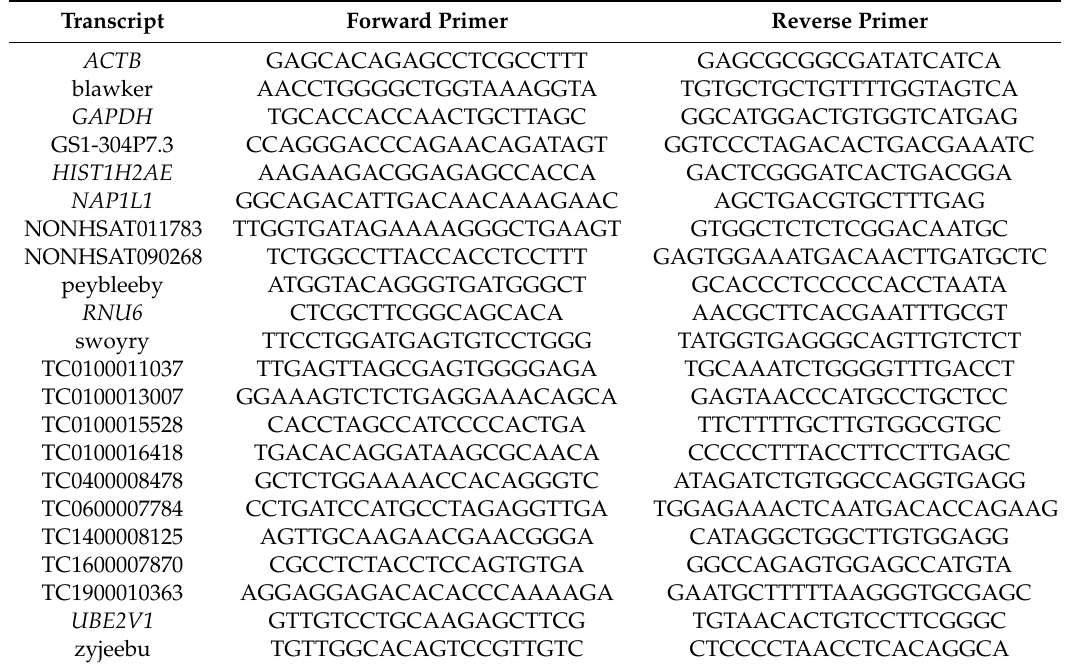
Table 7. PCR primers used for Real-Time PCR validation